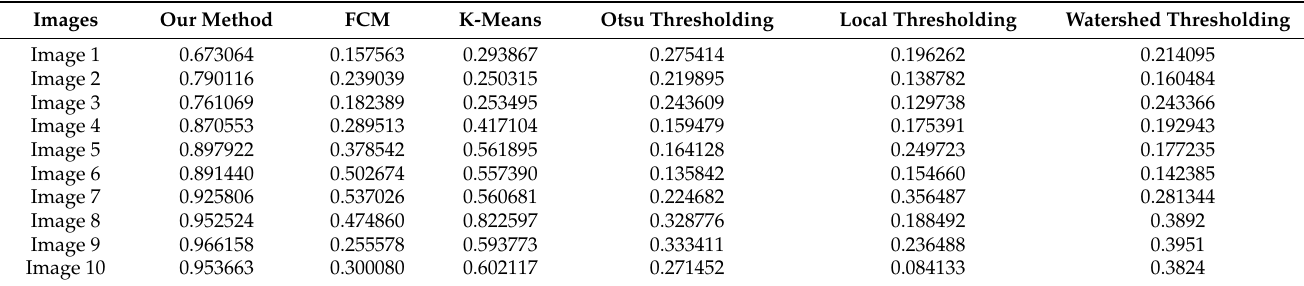
Table 7. Comparison between the results of our segmentation method on the KICA dataset and some well-known segmentation techniques using the correlation